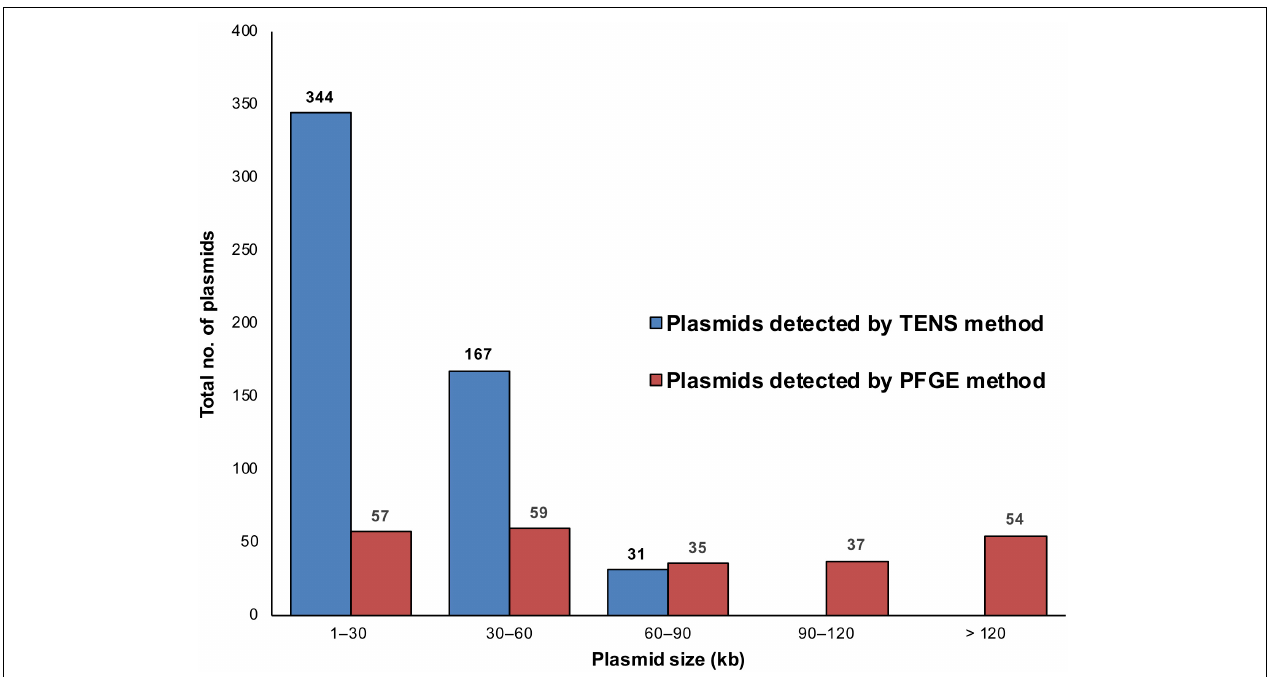
FIGURE 1 | The distribution of plasmids in the 222 S. aureus isolates according to plasmid size and method of detection, TENS and PFGE. Each method type is denoted by a different color, as shown in the color code at the right. The horizontal axis distributes plasmids according to the size windows shown. The vertical axis denotes the number of plasmids in each size window. Here, more plasmids were seen than the number of isolates as some isolates contained multiple